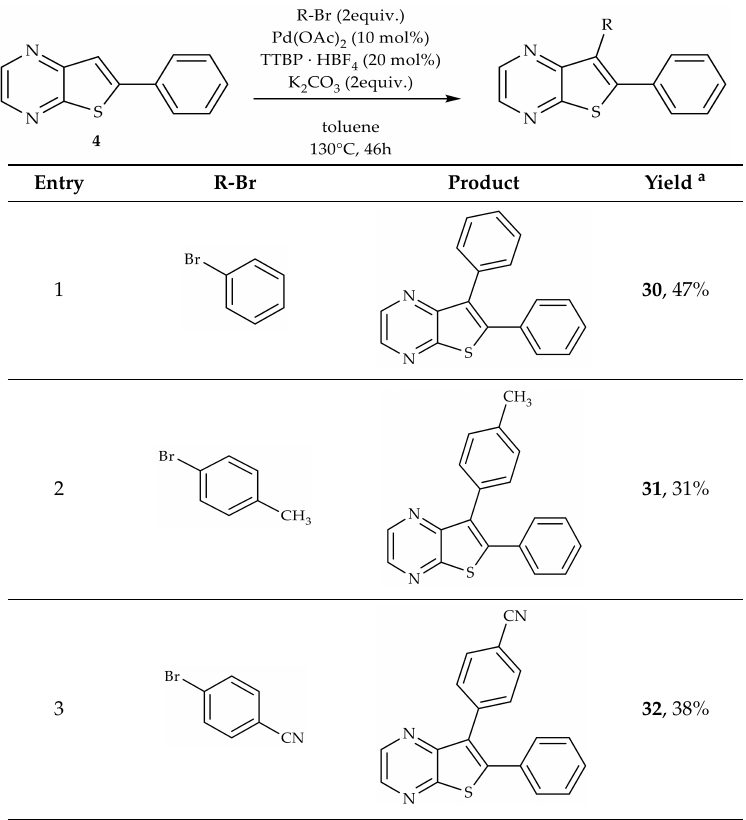
Table 8. Pd-catalyzed C–H arylation in C-3 of the 6-phenyl thieno[2,3- b ]pyrazine 4